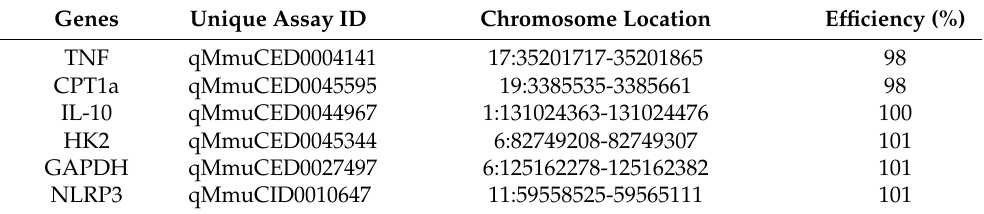
Table 2. Primer-unique assay identification (ID) number and chromosome location of PrimePCR™ SYBR ® Green Assay by Bio-Rad Laboratories. Genes Unique Assay